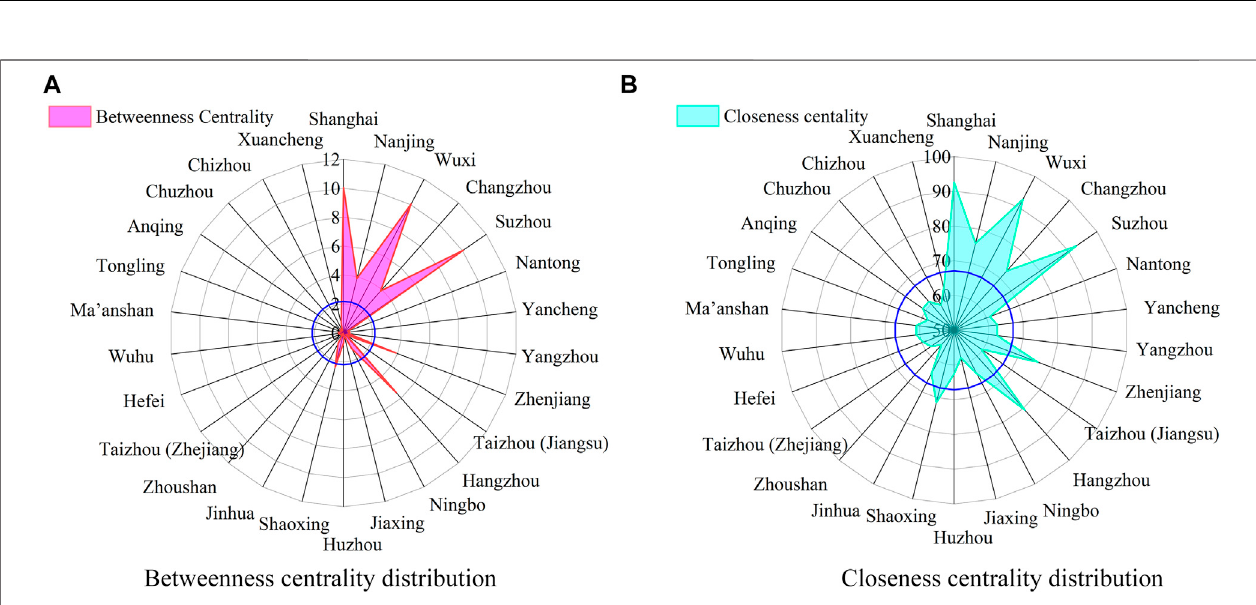
FIGURE 6 | Betweenness centrality and closeness centrality of water network in the YRDUA. (A) Betweenness centrality distribution (B) Closeness centrality distribution.